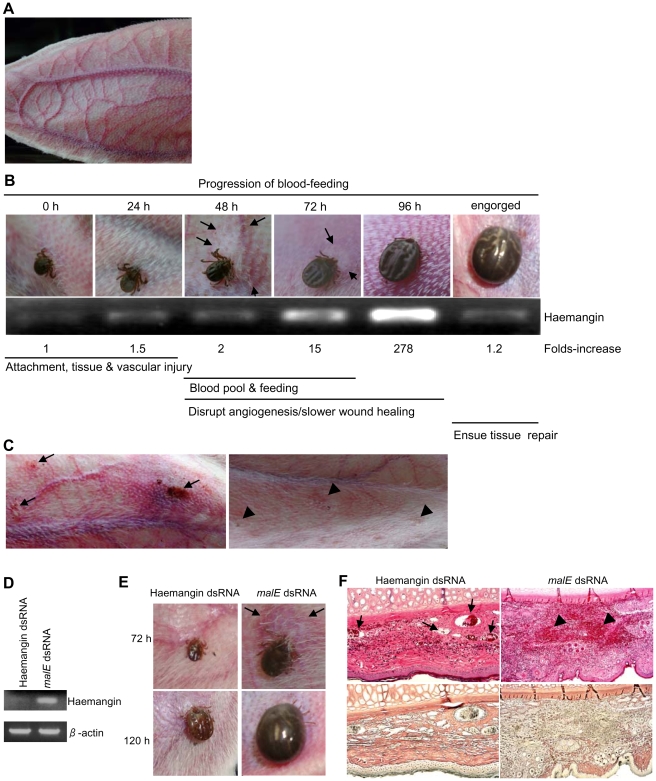
Haemangin's function in blood-feeding in vivo.(A) A naïve rabbit's ear as source of blood-meals. (B) Blood-feeding progression and engorgement of adult H. longicornis. Semi-quantitative RT-PCR was performed. Expression of Haemangin-specific mRNA is shown. Arrows indicate areas of blood pool. (C) A rabbit ear showing feeding wounds after the engorged ticks dropped off the ear (arrows; left panel) and repaired wounds on day 10 post-dropping (arrowheads; right panel). (D) Gene silencing of Haemangin by RNA interference. Ticks were injected either with E. coli malE dsRNA (control) or with Haemangin dsRNA. RT-PCR analysis was performed. Expression of Haemangin-specific mRNA is shown. β-actin is shown as an internal control. (E) Effect of targeted gene silencing on blood-feeding by adult ticks. Images were captured at 72 h and 120 h post-feeding. Arrows indicate areas of blood pool. (F) Effect of targeted gene silencing on angiogenesis in vivo. H&E- and silver nitrate–stained sections of a rabbit ear at 120 h tick post-feeding, revealing capillaries and venules (arrows) and area of blood pool (arrowheads) (magnification×100).